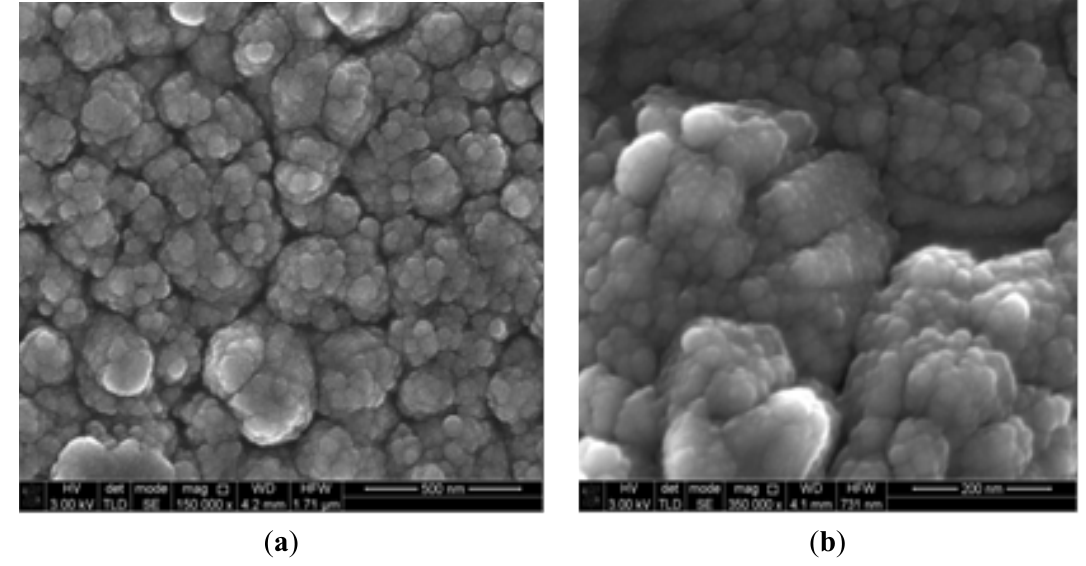
Figure 6. ( a ) A typical SEM image of glass/FTO/AD-CdTe surface with magnification of 150,000 and ( b ) an SEM image of glass/FTO/ZnS/CdS/HT-CdTe surface with magnification of 350,000. Scale bar: (a) 500 nm; (b) 200